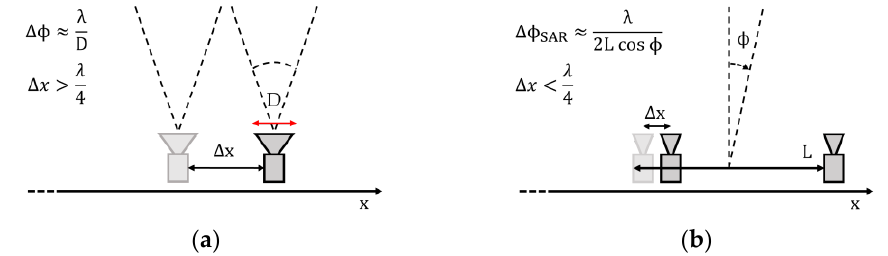
Figure 6. Radar imaging principle.